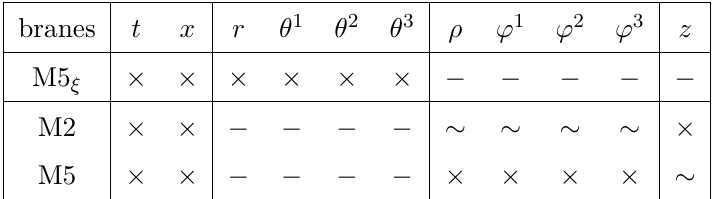
Table 5 . The brane picture underlying the 2d SCFT described by M2 and M5 branes as defects within the 6d N = (2 , 0) SCFT living on the worldvolume of the M5